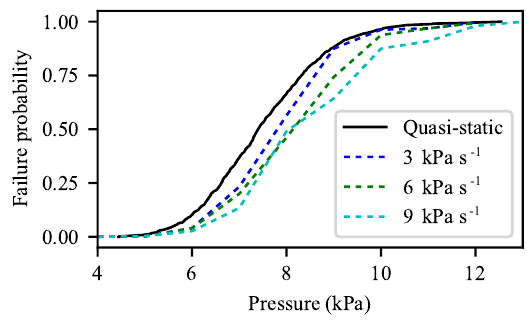
Figure 13. Effects on fragility curves of the avalanche loading rate. Fragility curves have been computed using the ECDF reliability